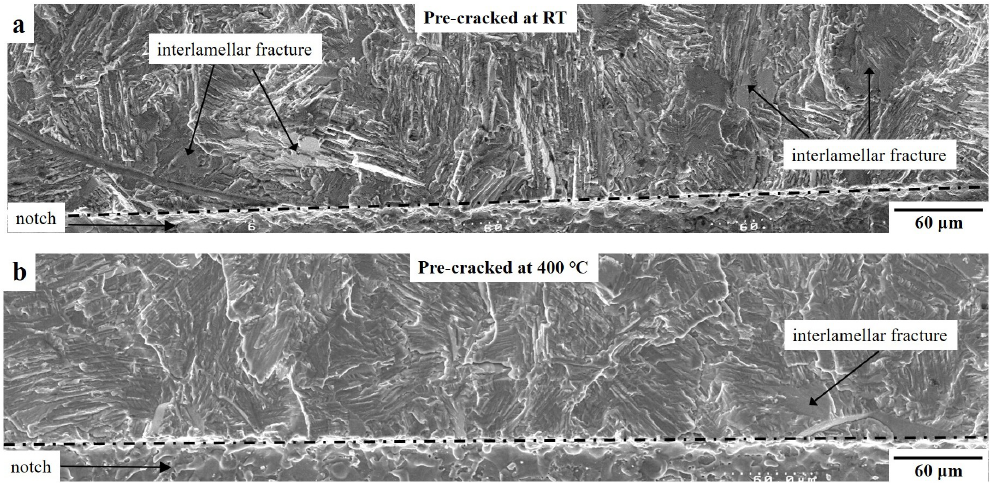
Figure 8. Precracks generated by cyclic tension–tension loading with an R ratio of 0.1 at ( a ) RT and ( b ) 400 °C.